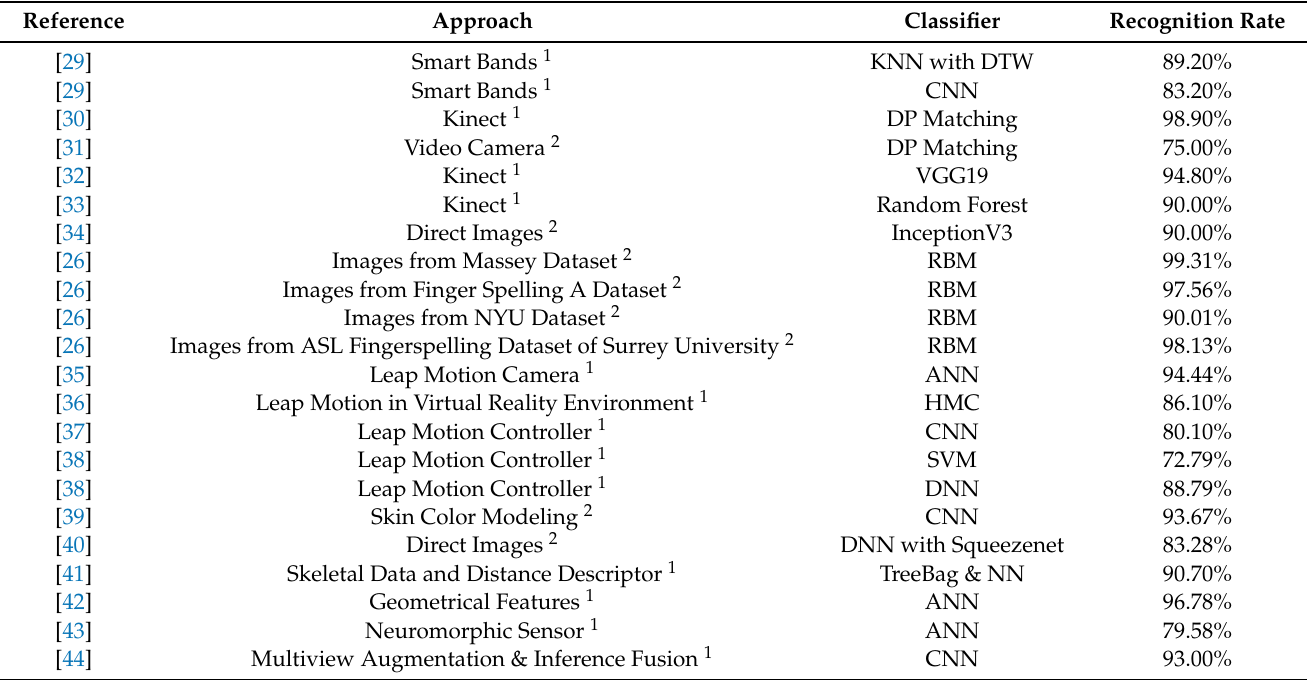
Table 1. Previous works performances at a glance including the approach and classifier